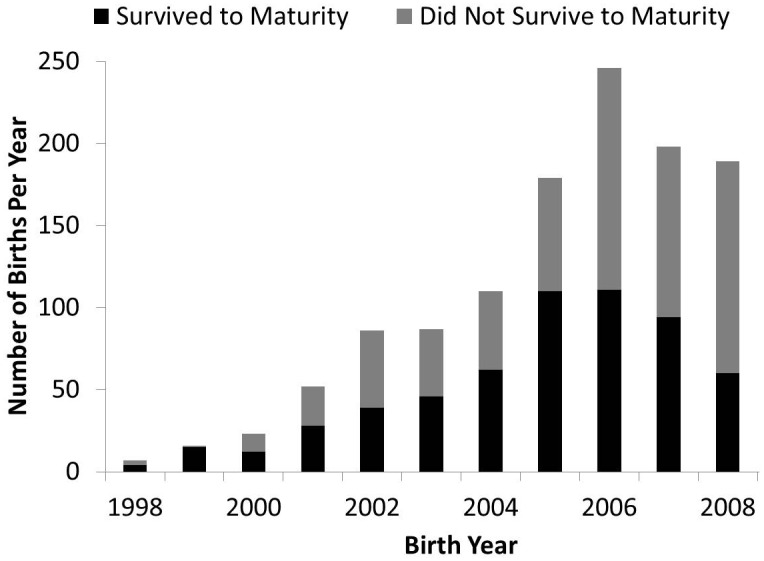
Proportion of snails born each year that survived to maturity for captive Achatinella lila from 1998 to 2008.Snails of this species reach maturity at approximately four years of age. The sum of snails that survived to maturity (black) and snails that did not survive to maturity (gray) indicates the total number of snails born in a given year. The number of births and the number of snails surviving to maturity peaked in 2006.